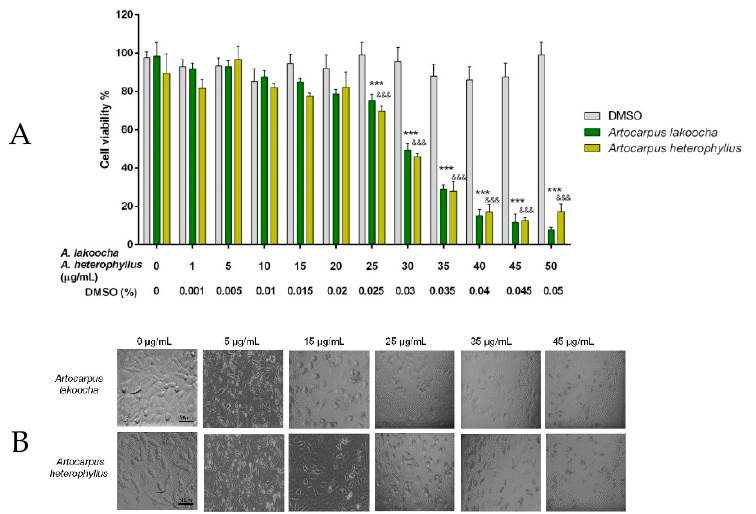
Figure 3. Effects of flower aqueous extracts of Artocarpus lakoocha Roxb. and Artocarpus heterophyllus Lam. on Caco ‐ 2 cell viability. ( A ) The bars indicate percent cell viability of cells treated with one of the two floral extracts with the indicated concentrations (ranging from 0 to 50 μ g/mL) for 48 h and subjected to a 3 ‐ (4,5 ‐ dimethylthiazol ‐ 2 ‐ yl) ‐ 2,5 ‐ diphenyltetrazolium bromide (MTT) assay. Data are representative of three replicates and shown as mean ± standard deviation; *** p < 0.001 vs. Artocarpus lakoocha Roxb. untreated group; &&& p < 0.001 vs. Artocarpus heterophyllus Lam. untreated group. ( B ) Effects on Caco ‐ 2 cell cytotoxicity after 48 h treatment with aqueous solution extracts of Artocarpus lakoocha Roxb. and Artocarpus heterophyllus Lam. Only concentrations of 0, 5, 15, 25, 35, and 45 mg/mL are shown in the image.